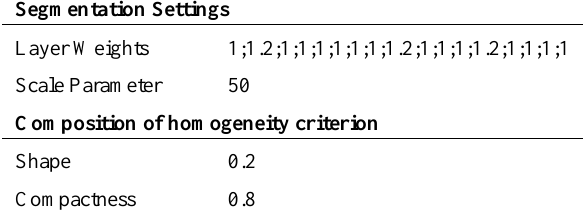
Table 1. Multi-resolution segmentation settings